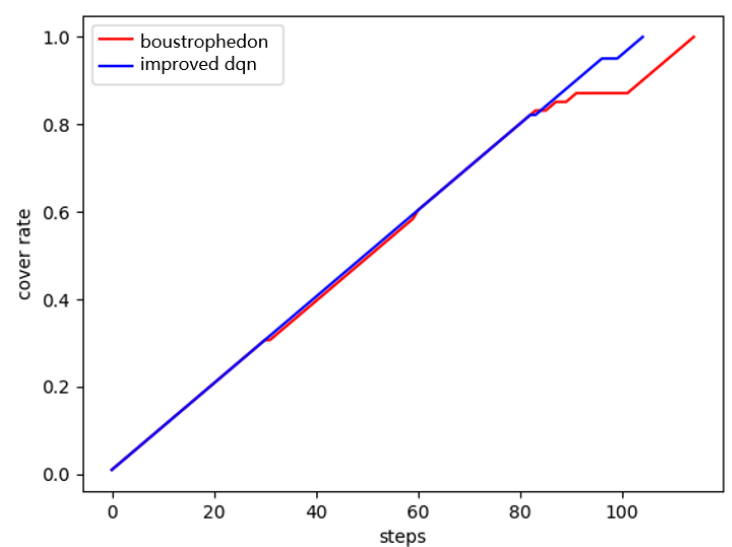
Figure 16. Coverage map.